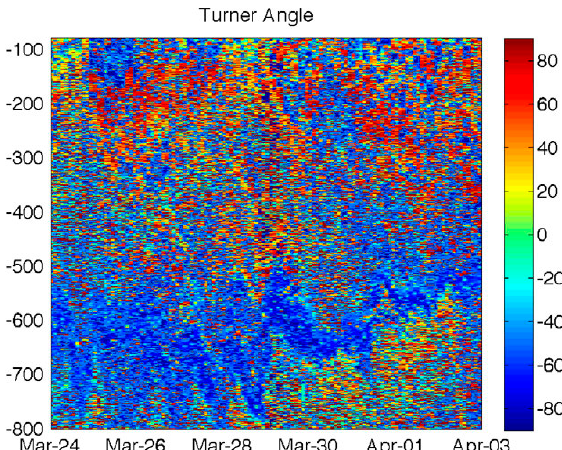
Fig. 6. – Turner angle for data sampled, values in the range [–90,